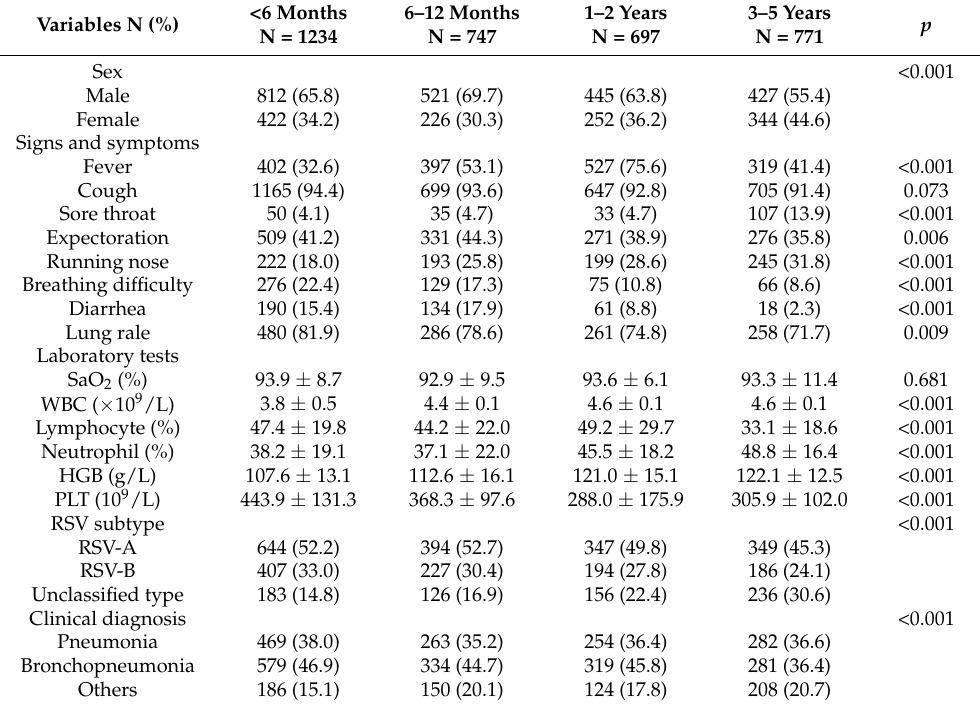
Table 2. Clinical characteristics of RSV-positive children in age